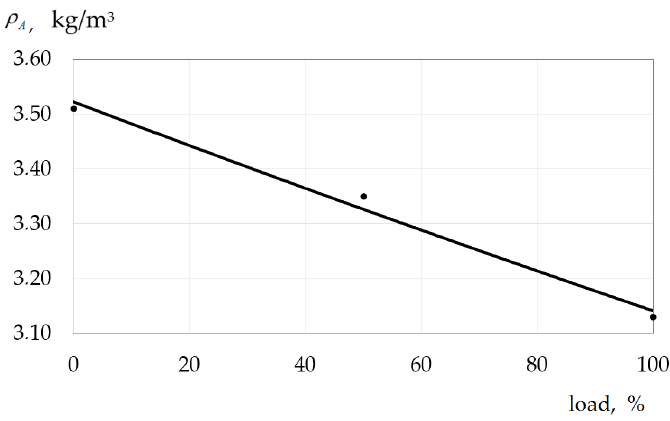
Figure 5. Dependence of air density at the combustion chamber inlet on the load value.